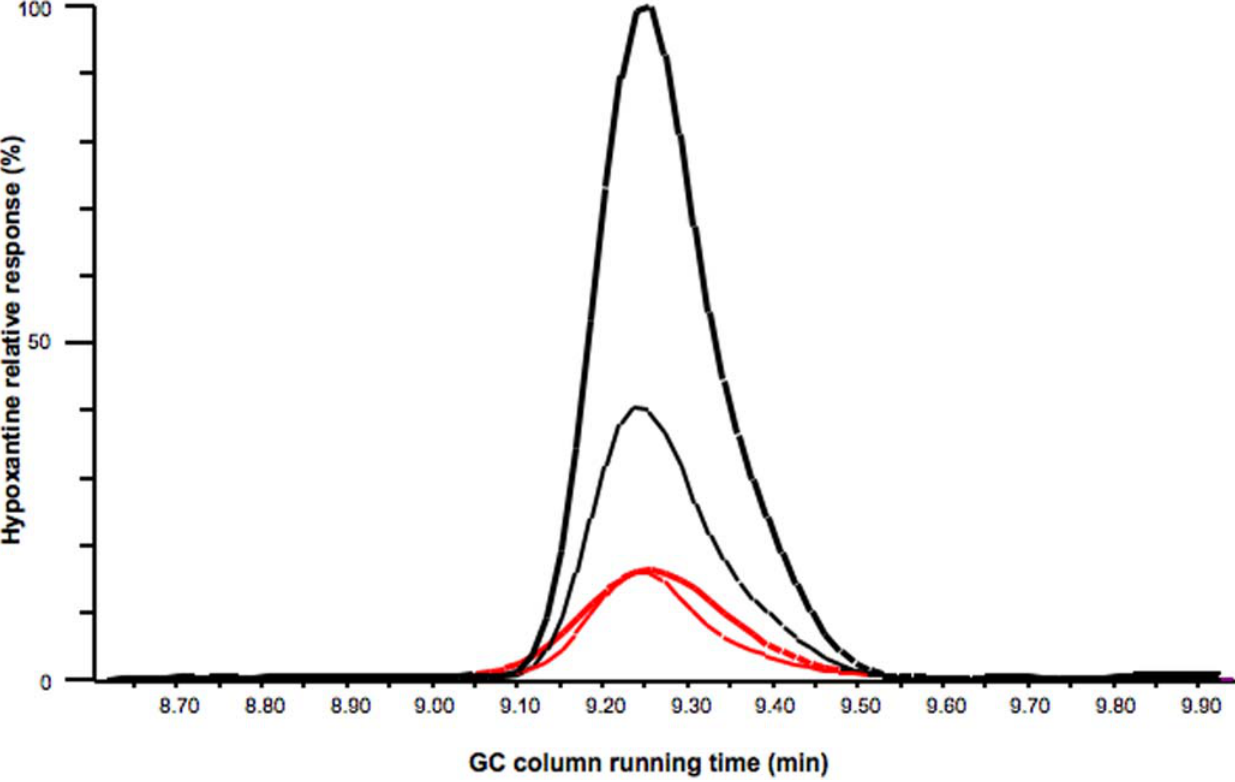
Figure 1. Mature P.falciparum infected erythrocytes accumulate high levels of hypoxanthine. Hypoxanthine was analyzed in the soluble fraction of lysates of human erythrocytes infected with P. falciparum at different times after infection in a synchronized culture. Lysates of uninfected erythrocytes cultured for the same times were used as controls. Shown are GC - selected reaction monitoring MS ion plots using the m/z 365.2 to m/z 251.2 product ion MS/MS transition. Hypoxanthine accumulated in cultured uninfected erythrocytes (red lines) and P. falciparum infected erythrocytes (black lines) is shown. Infected erythrocytes at 33 h (mature trophozoites, thick lines) and 40 h (schizonts, think lines) were purified from synchronized cultures of 2% parasitemia.